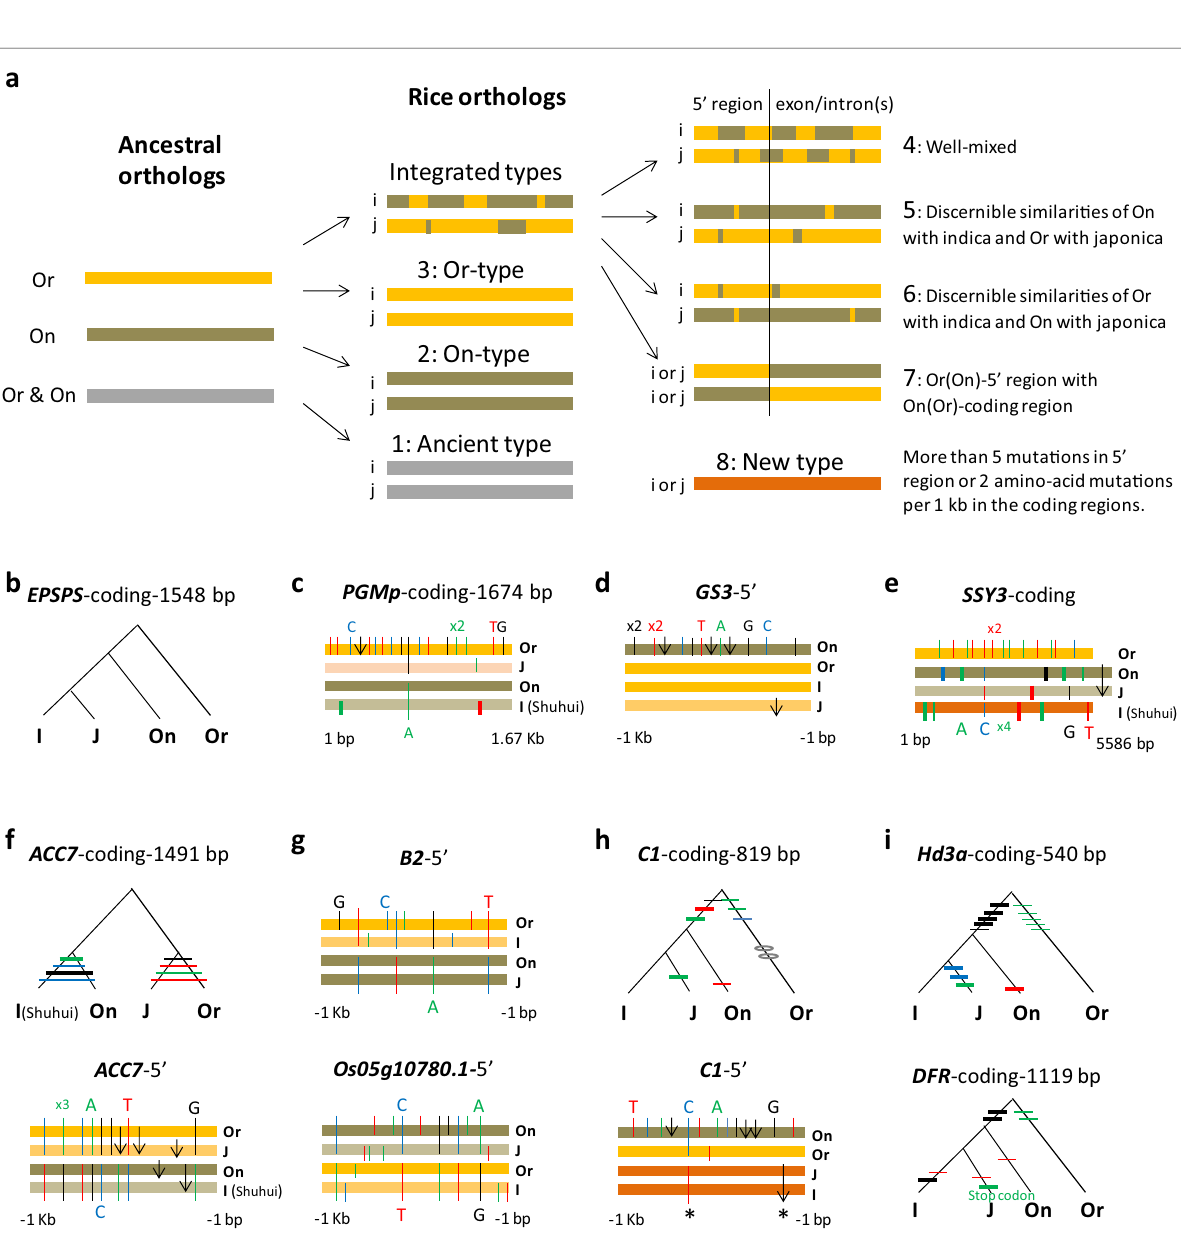
Fig. 3 Types of genes in O. sativa. a A flow chart showing the movement of parental genes into genomes of O. sativa and eight gene types in standing rice . The left panel classifies the parental orthologs into Or ( O . rufipogon , in yellow) and On ( O . nivara , in dark green) and their common ones (in dark red). The middle and right panels show the current types of rice genes observed in genomes of indica (i) and japonica (j), with the integrated types further broken down into four classes, along with new alleles, in the right panel. b A genealogy of Type 1 gene. The example by EPSPS of the shikimate pathway shows no changes. c A genealogy of Type 2 gene. A resemblance to On sequence is seen at PGMp of glycolysis. d A genealogy of Type 3 gene. A resemblance to Or sequence is shown by GS3 , a regulator of grain size. e A genealogy of Type 4 gene. The well-mixed type is found in the coding regions of SSY3 in starch synthesis. f Type-5 gene genealogies with Or-j and On-i associations. It appears in both 5 ′ and coding regions of ACC7 , a gene likely involved in ethylene synthesis. g Type-6 gene genealogies with Or-i and On-j associations. 5 ′ regions of two genes, B2 (a regulator on the anthocyanin pathway) and an unknown gene, show the associations. h Genealogies of a Type 7 gene. Different origins of 5 ′ and coding regions is at C1 . i Genealogies of Type 8 genes. Mutations causing multiple amino-acid changes in Hd3a led to the Nipponbare allele of Hd3a . And an early stop codon led to a new allele of OsDFR in japonica lineage. Gene genealogies follow the format of Fig.